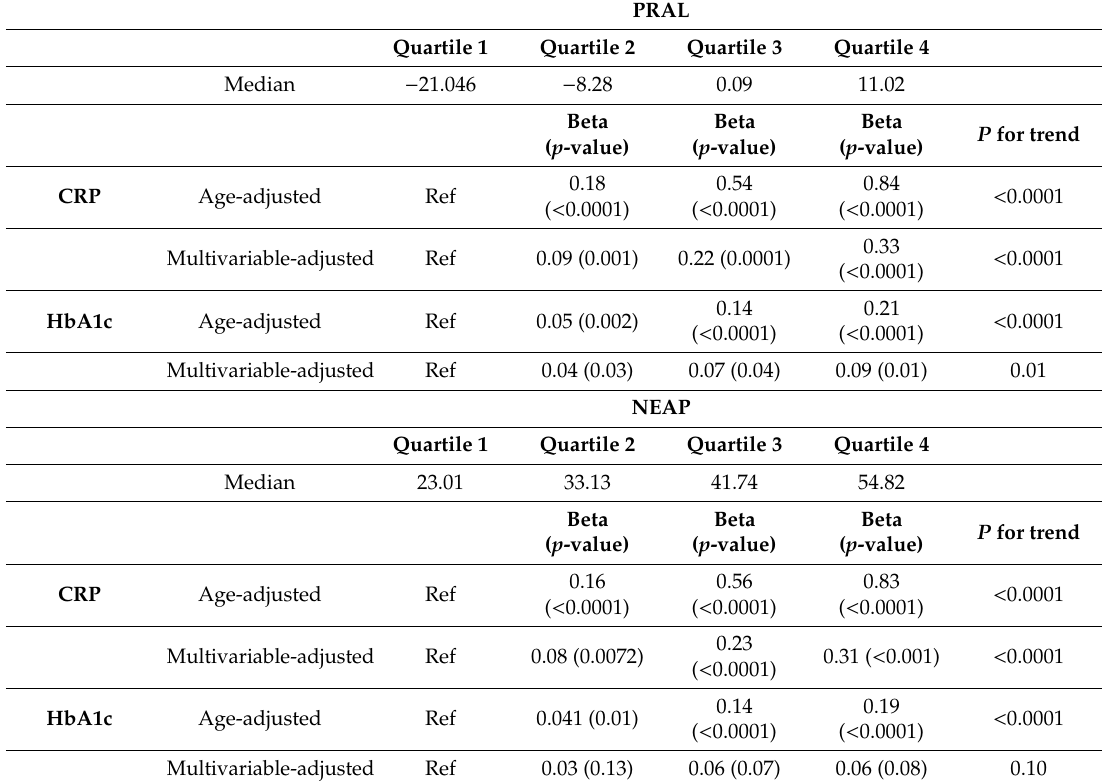
Table 3. Age-adjusted and multivariable-adjusted associations between dietary acid load (PRAL and Net Endogenous Acid Production (NEAP)) and biomarkers (C-reactive protein (CRP) and hemoglobin A1c